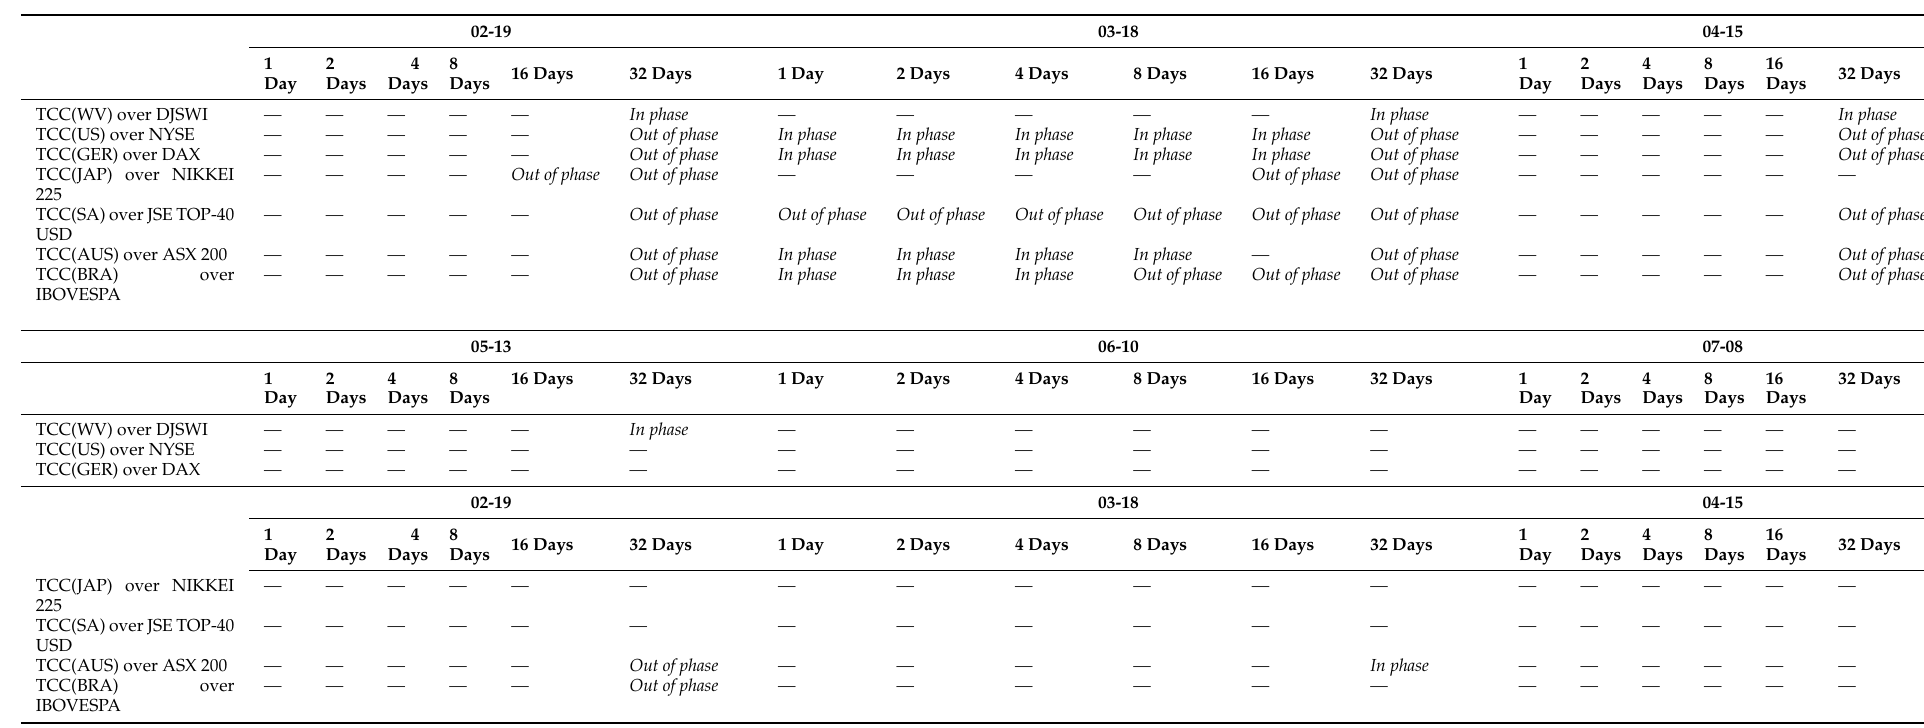
Table 3. Summary of the different phase differences detected from the wavelet coherence analysis. Source: Own elaboration.